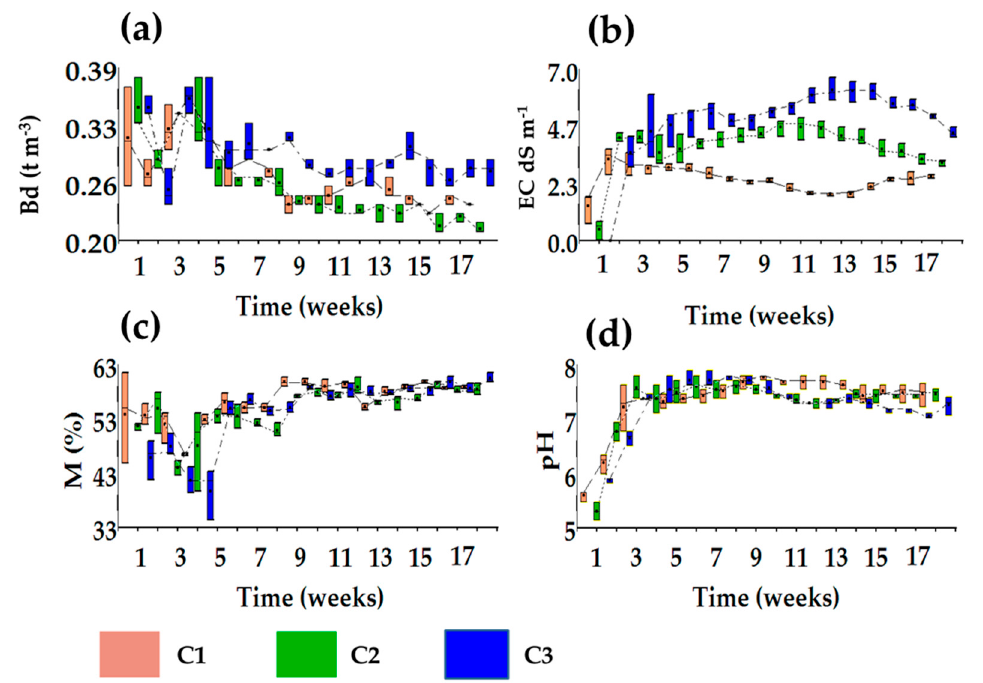
Figure 3. Box graphic of parameters’ evolution in compost: C1, C2 and C3 throughout 18 weeks. M%: moisture ( a ); pH ( b ); Bd: t·m − 3 ( c ) and EC: dS m − 1 ( d ).